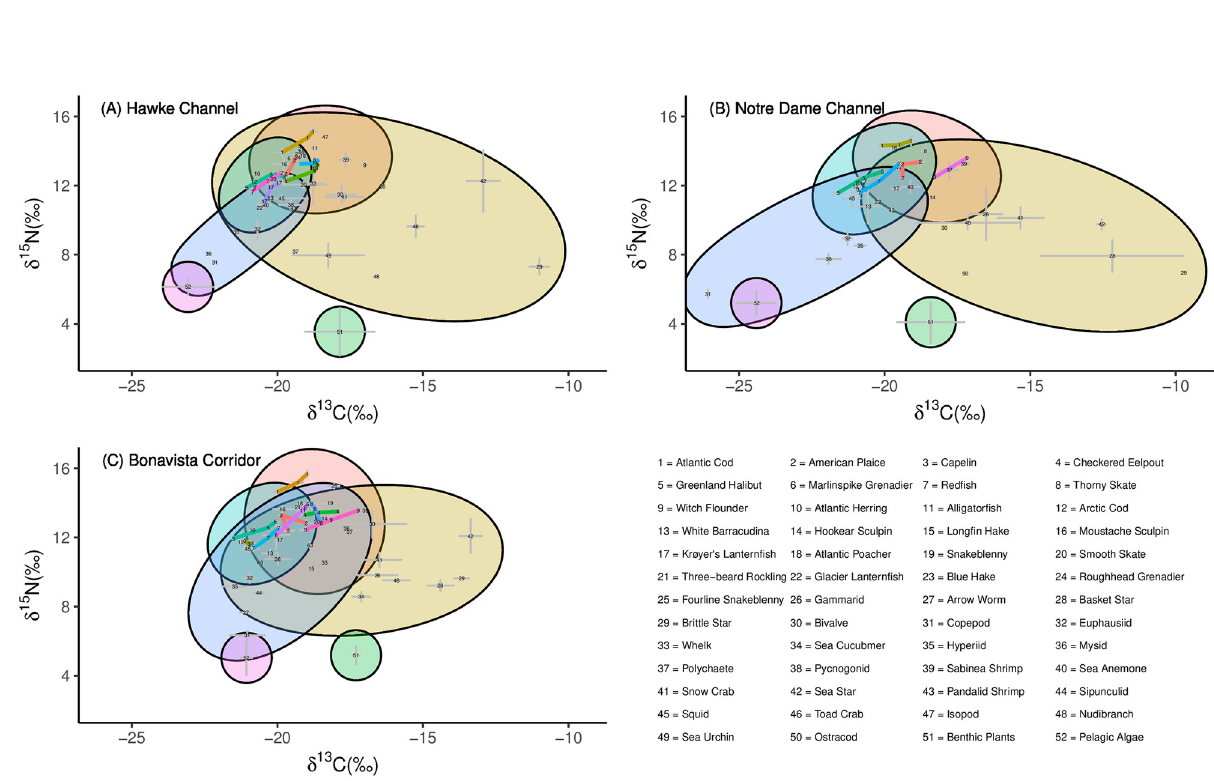
Fig 2. Stable carbon and nitrogen isotope values (mean ± SE) for dominant species within (A) the Hawke Channel, (B) the Notre Dame Channel, and (C) the Bonavista Corridor. Ovals represent the group categories of pelagic fish (green), benthic fish (red), pelagic invertebrates (blue), benthic invertebrates (yellow), pelagic algae (purple), and benthic plants (dark green). In cases where a species demonstrated ontogenetic variation in their isotopic signatures, these species are represented by three points connected by linear lines. Species abbreviations are defined in Table 1.